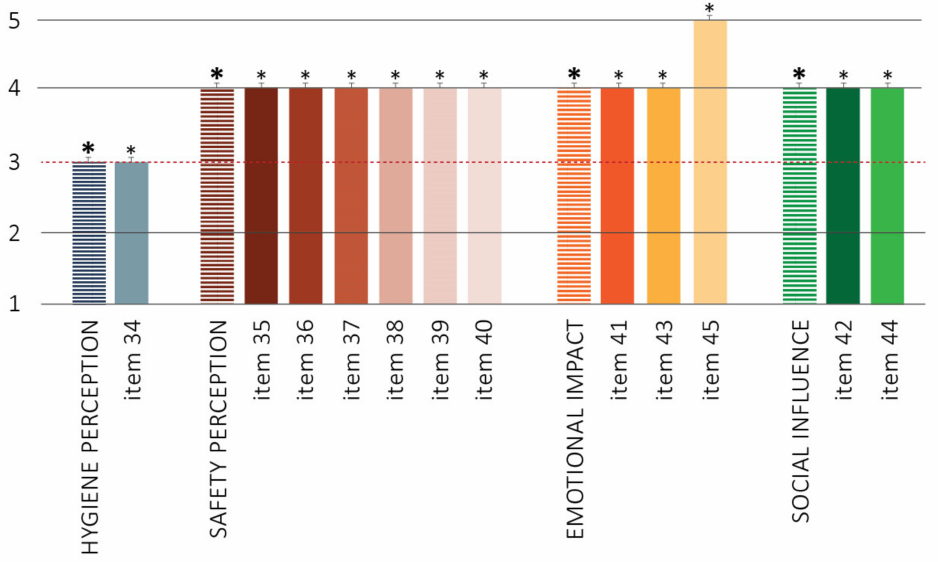
Figure 8. Wayfinding systems: median values of the scores given by the users, differentiated per dimension and item. * dimension, p < 0.05; * item, p < 0.05. Own